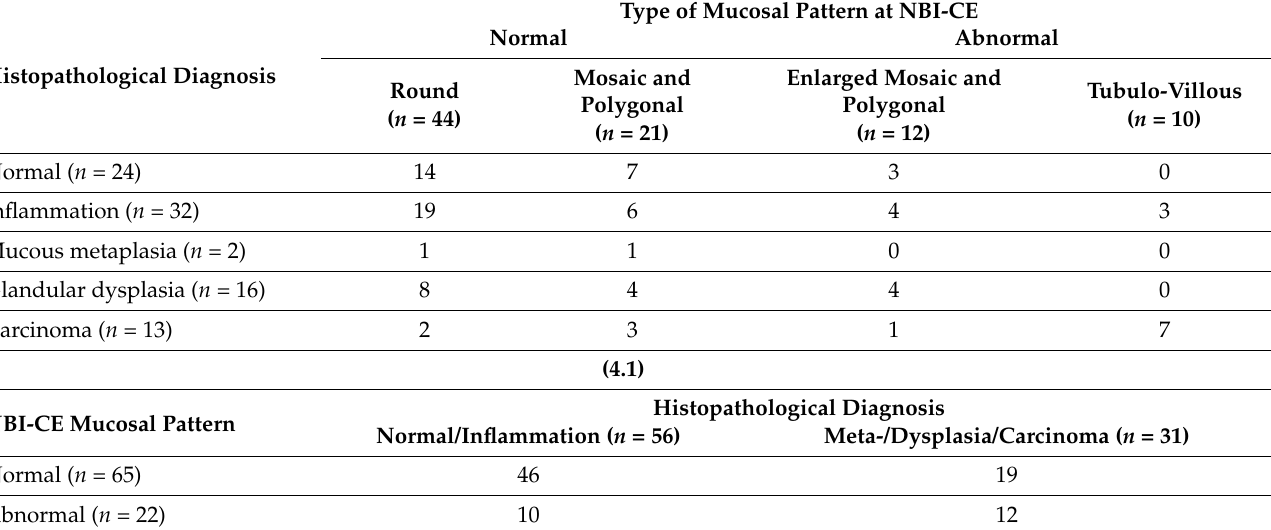
Table 4. Most severe histopathological diagnoses of biopsy sites and categories of gastric mucosal patterns of dogs identified in 87 endoscopic still images obtained during NBI-CE. 4.1. 2 × 2 table for histopathological diagnosis and NBI-CE mucosal